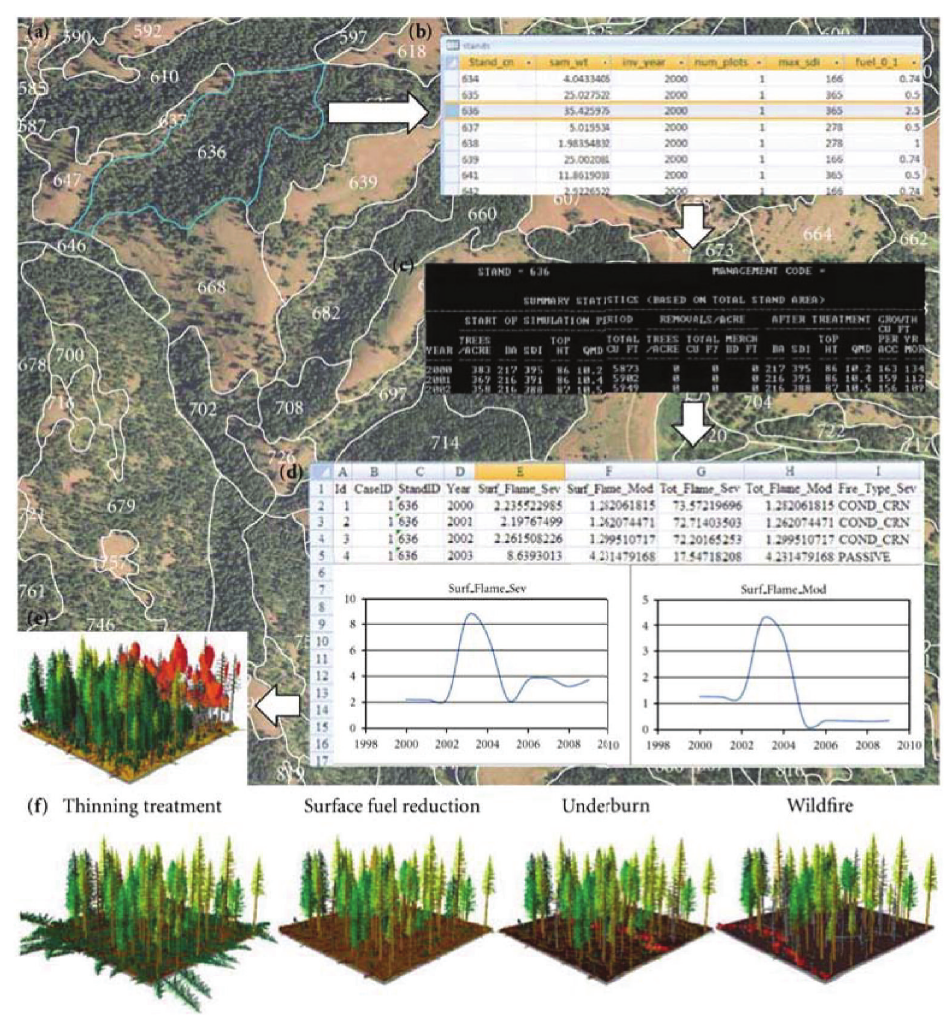
Figure 5: ArcFuels interface within ArcMap, showing images from an analysis of a fuel treatment prescription calling for a sequence of thinning, surface fuel reduction, underburn, and wildfire with the supplied demonstration data. (a) Digital orthophoto with stand boundaries for the project area; (b) access database containing forest and fuel information; (c) simulating vegetation dynamics and wildfire with FVS (d) viewing the output spreadsheets, including ArcFuels-generated graphs from the simulation showing fire behavior variables in the potential fire output report; (e) SVS image depicting the wildfire pretreatment; (f) SVS images depicting the treatment sequence including the wildfire behavior after the treatment was